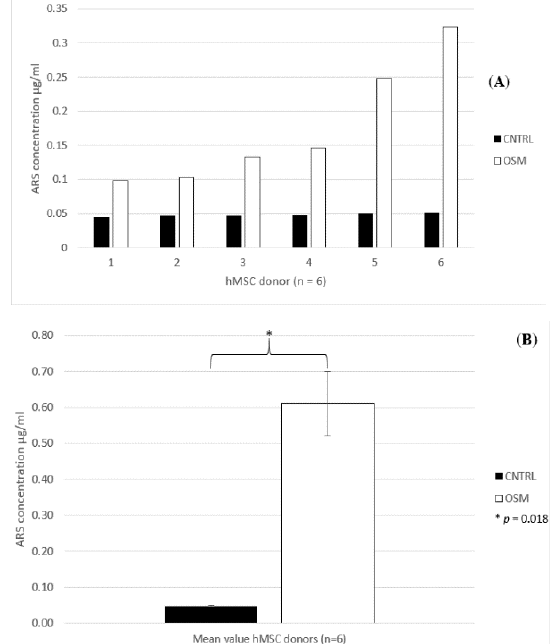
Figure 4. ( A ) Individual activity bound to each dish for donors 1–6 treated in osteogenic media (OSM) and the negative control group (CNTRL) measured by 18 F-activimeter analysis. ( B ) Mean activity ( n = 6 ) bound to the dishes in osteogenic media (OSM) and the negative control group (CNTRL) measured by 18 F-activimeter analysis, +/ − standard deviation, p = 0.012; * = significant difference between the two groups, p ≤ 0.05.